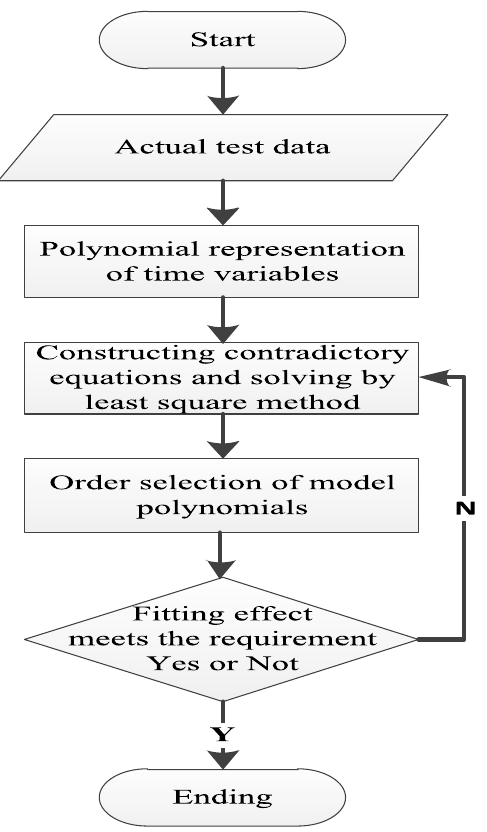
Figure 1. Process of missing flight data fitting and correction.